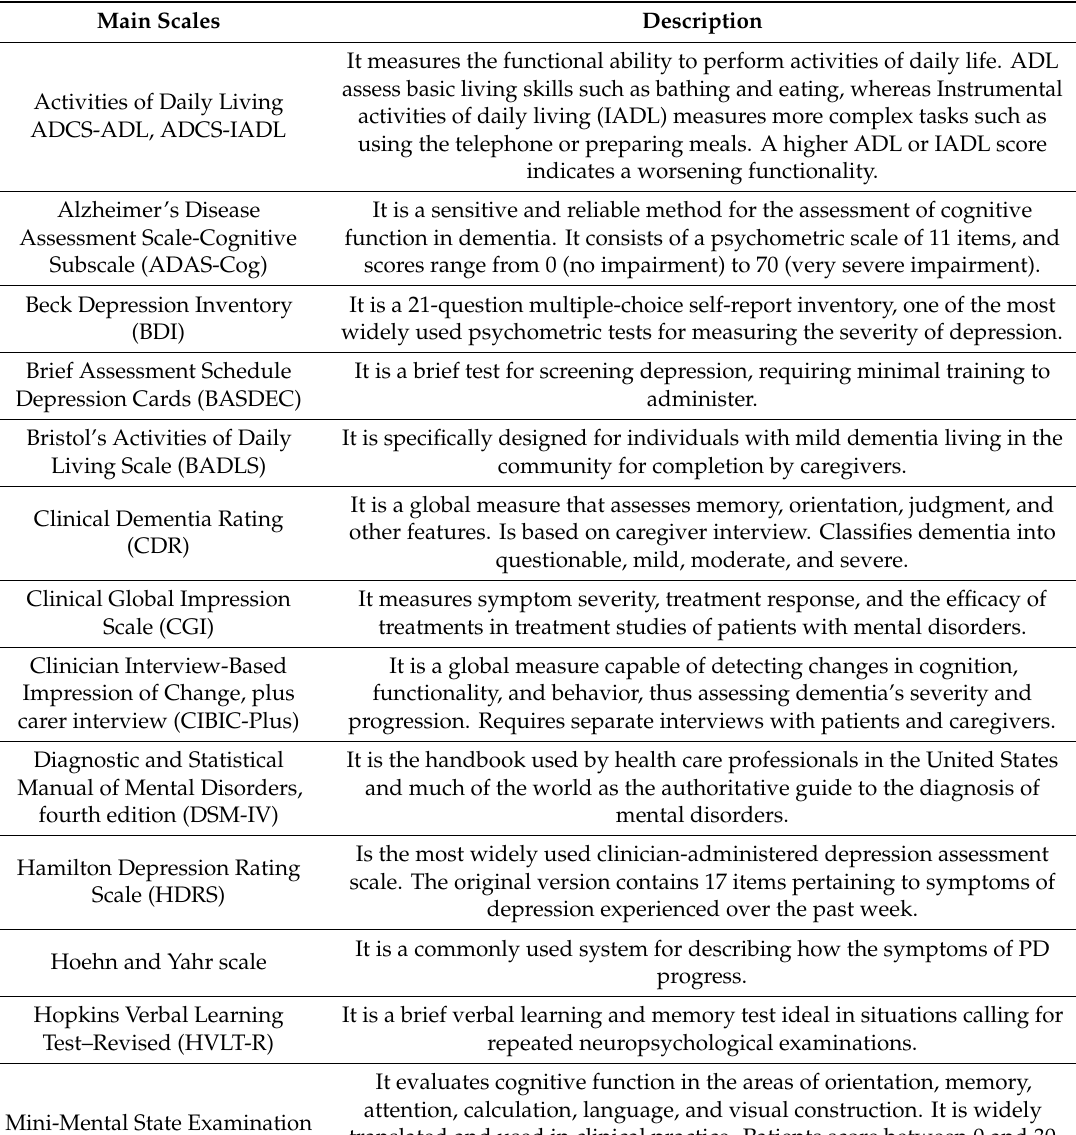
Table 3. Summary of main scales used for assessment of Parkinson’s and Alzheimer’s Disease ([47] with